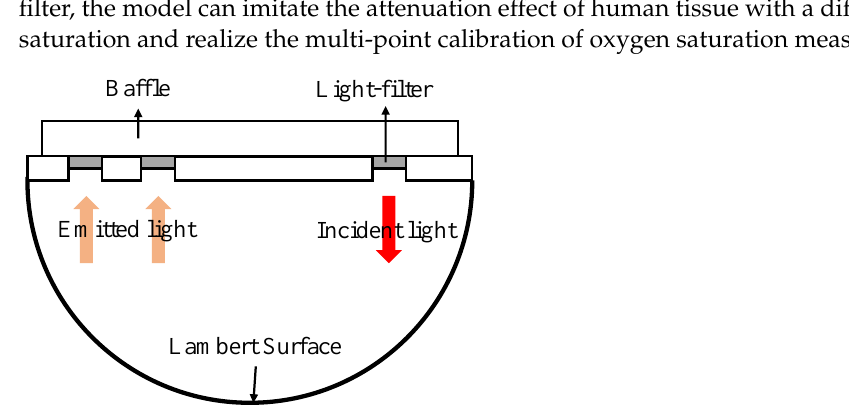
Figure 4. Diagram of the optical integrating sphere